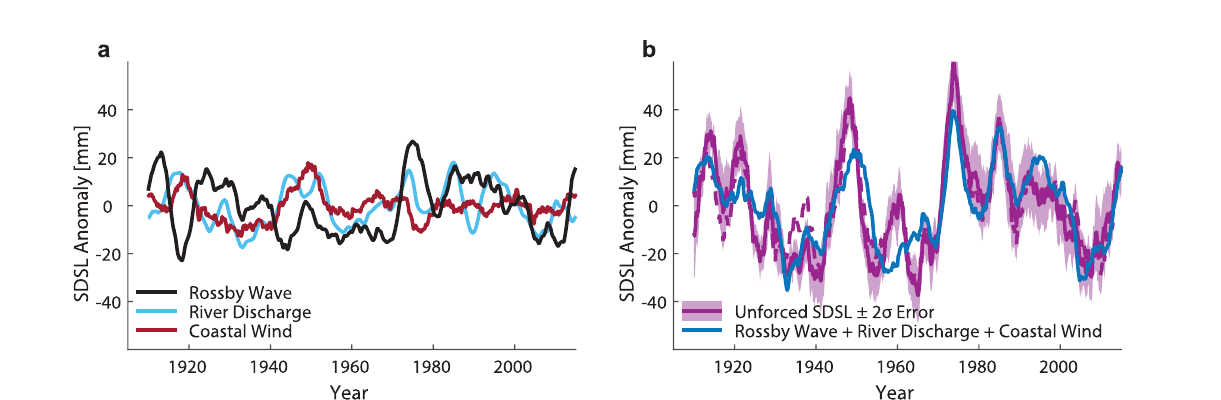
usedtoproducetheindexasa2 σ standarderror.Overlaidisanestimateofinternal climatevariabilityderivedfromthesumofthethreeprocessesin( a )(seeMethods). All time series are plotted over the overlapping period 1910 – 2015 and have been smoothed with a moving average fi lter with a cutoff period of 48 months. The correlation between unforced SDSL and the estimate of internal variability is r =0.81 (CMIP5) and r =0.8 (CMIP6),